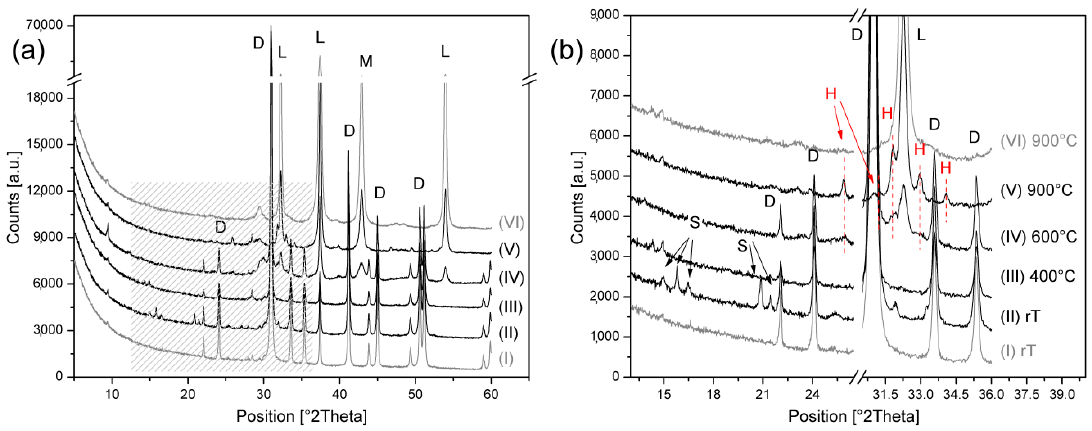
Figure 3. ( a ) XRD patterns of untreated (grey patterns) and treated (black patterns) Angera stone at room temperature (rT) and after heating at 400, 600 and 900 °C. ( b ) zoom of (a) showing the phase transformation occurred with heating. D = dolomite, L = lime, M = MgO, S = struvite, H = hydroxyapatite.